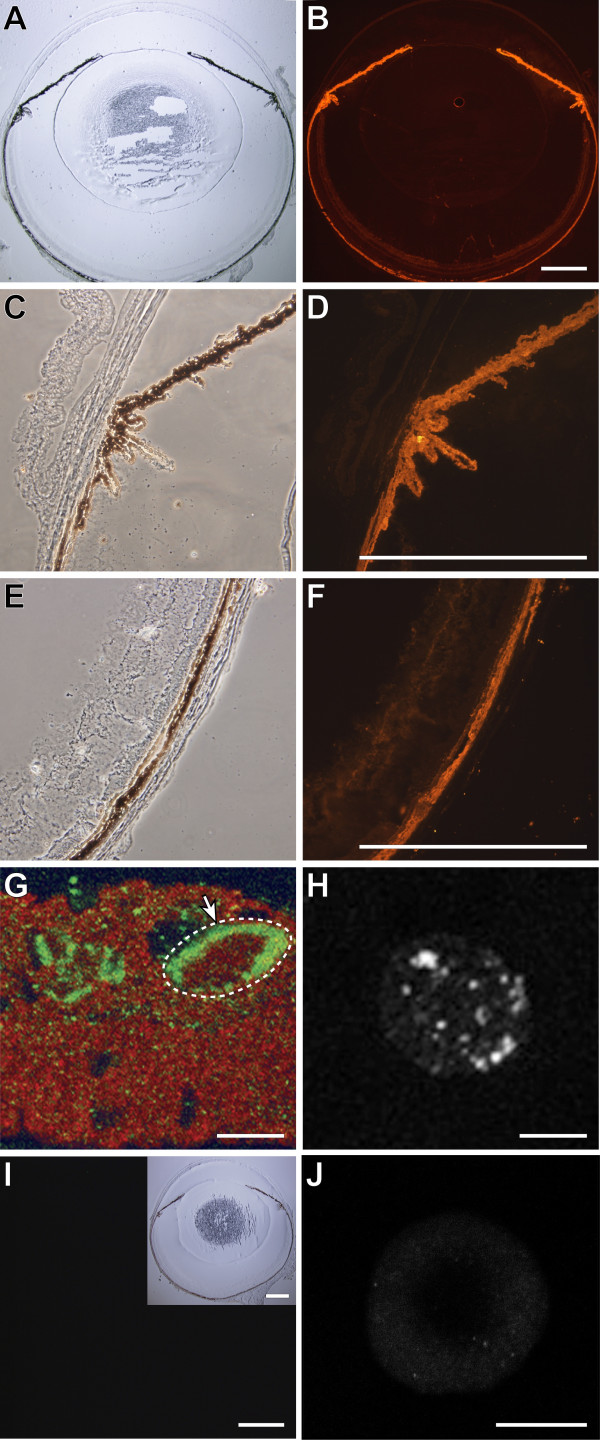
GPNMB localizes to multiple pigmented tissues of the eye and ocular APCs. Cryosections of whole eyes from wild-type C57BL/6J mice were imaged in brightfield or phase illumination. GPNMB protein localization was imaged by fluorescent immunohistochemistry and confocal microscopy (red). GPNMB is present in: (A, B) multiple pigmented tissues of the eye, (C, D) iris and pigmented epithelia of the ciliary body, and (E, F) choroid. (G) Iris of normal C57BL/6J mouse showing GPNMB (red) within cells labeled by F4/80 (green). An 8 micron Z-series composite demonstrating F4/80 labeling the border of a single cell (dashed white circle) containing GPNMB. (H) BM derived dendritic cell from D2-Gpnmb+ marrow differentiated in cell culture showing punctate expression of GPNMB, (I, J) Negative controls were labelled and imaged with identical conditions and exhibited negligible signal. (I) Eyes from D2 mice (homozygous for GpnmbR150X) have no signal for GPNMB, an inset on right hand corner shows the brightfield image of the same section. (J) BM derived dendritic cells from D2 mice have no staining for GPNMB. Scale bars A-F, I = 500 μm, G, H, J = 10 μm.